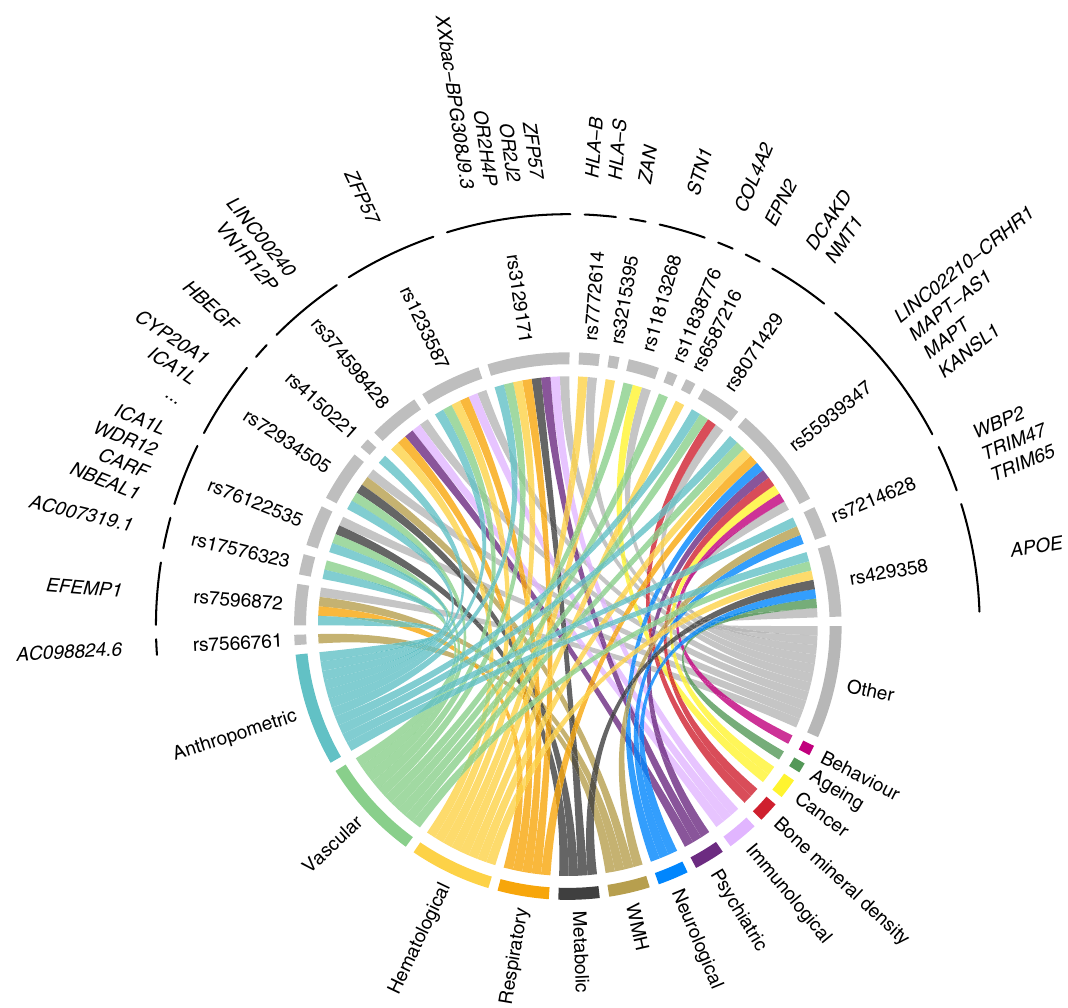
Fig. 4 PhenoScanner disease/trait annotation for WMH, FA and MD loci. Only loci with a disease/trait annotation appear on this fi gure. For better visibility, we assigned each trait to one category with a speci fi c